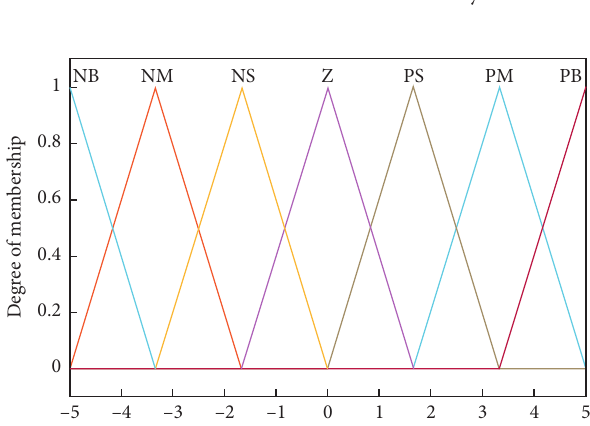
Figure 4: The membership function graph of e , ec , Δ K Table 1: Δ K p of fuzzy control rules.